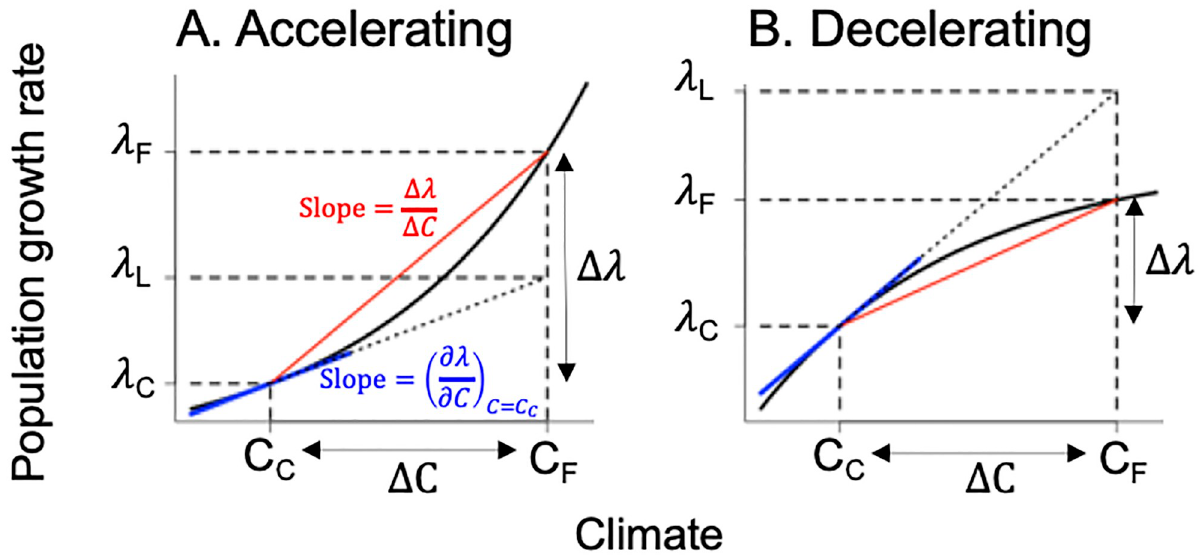
Fig 1. Non-linear effects of climate on population growth rate. Population growth rate is in general a non-linear function of climate (solid black lines), either: A. accelerating; or B. decelerating. λ C and λ F are the current and future growth rates at the current and future values of a climate variable; C C represents current and C F represents future climate. Blue lines show the slope of the population growth rate vs. climate evaluated at the current climate (i.e., “climate sensitivity”). The slope of the red line (“climate responsiveness”) is the ratio of the actual change in population growth Δλ to the actual change in climate Δ C (C F -C C ). λ L is the linear projection of the future population growth rate using the sensitivity, which underestimates λ F when population growth is an accelerating function of climate but overestimates λ F when population growth is a decelerating function.